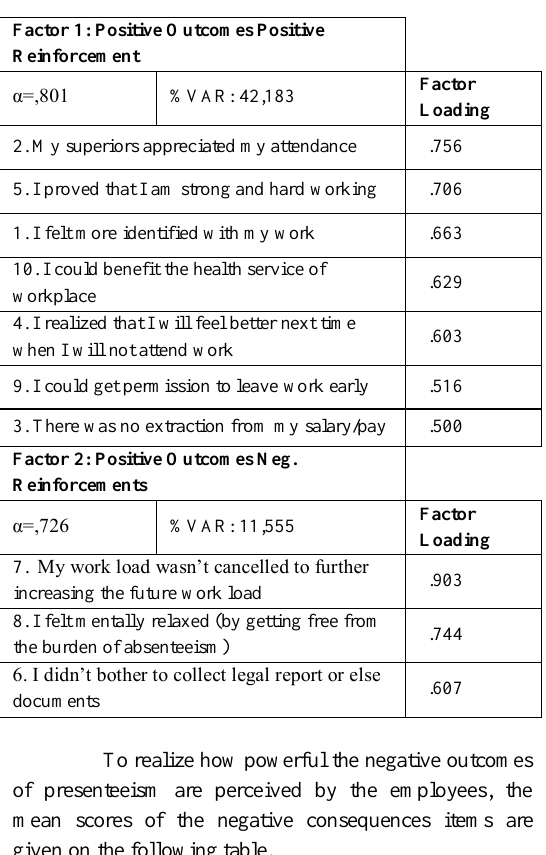
Table 10: Results of Exploratory Factor Analysis for